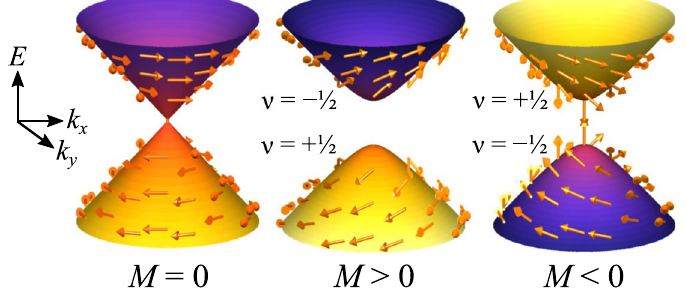
Figure 1. Physics of topological insulator surface states. The surface states of TIs host 2D Dirac surface states with linear dispersion when there is no magnetic Zeeman interaction ( M = 0). Their characteristic spin- momentum locking is evident from the superimposed arrows indicating the spin. When magnetization is added with M > 0, a gap is generated creating two topologically nontrivial bands with Chern numbers ν = ± 1/2. When the sign of the magnetization is flipped with M < 0, the Chern numbers of the resulting bands also